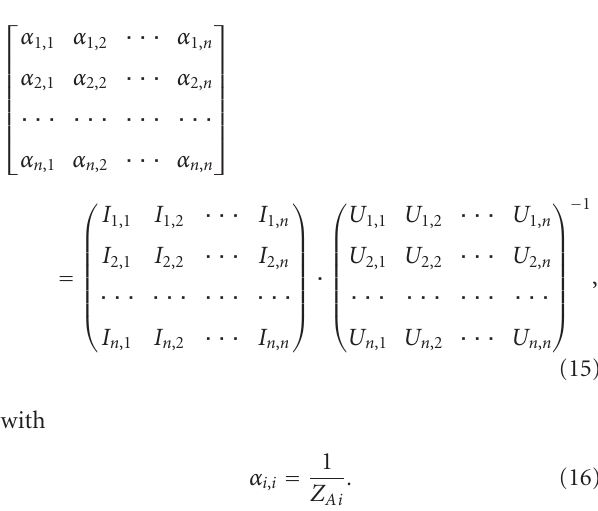
Finally, the currents that are coupled in the antenna ports while only “i” is fed are given by the relation